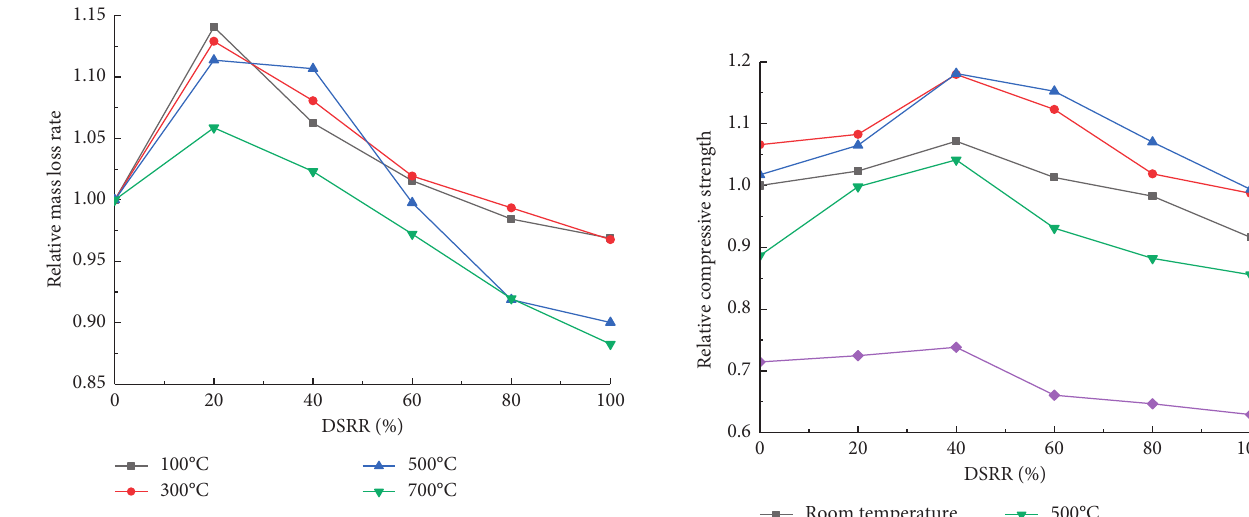
Figure 10: Relation between relative mass loss rate and DSRR.